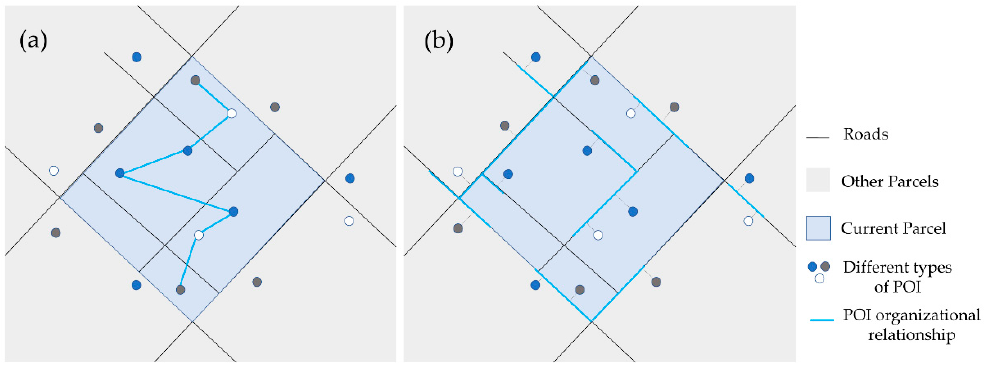
Figure 1. Comparison of organizational relationships between POIs: ( a ) Existing studies use the linear relationship between POIs; ( b ) In this study, we make use of the non-linear relationship between POIs.